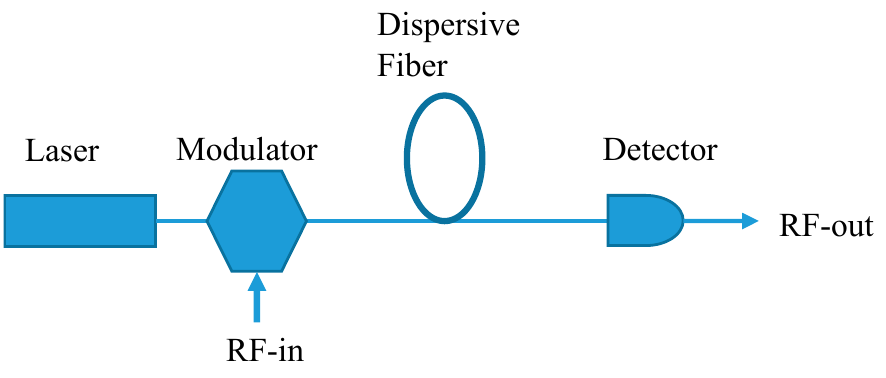
Figure 1. System Figure 1. System schematic.